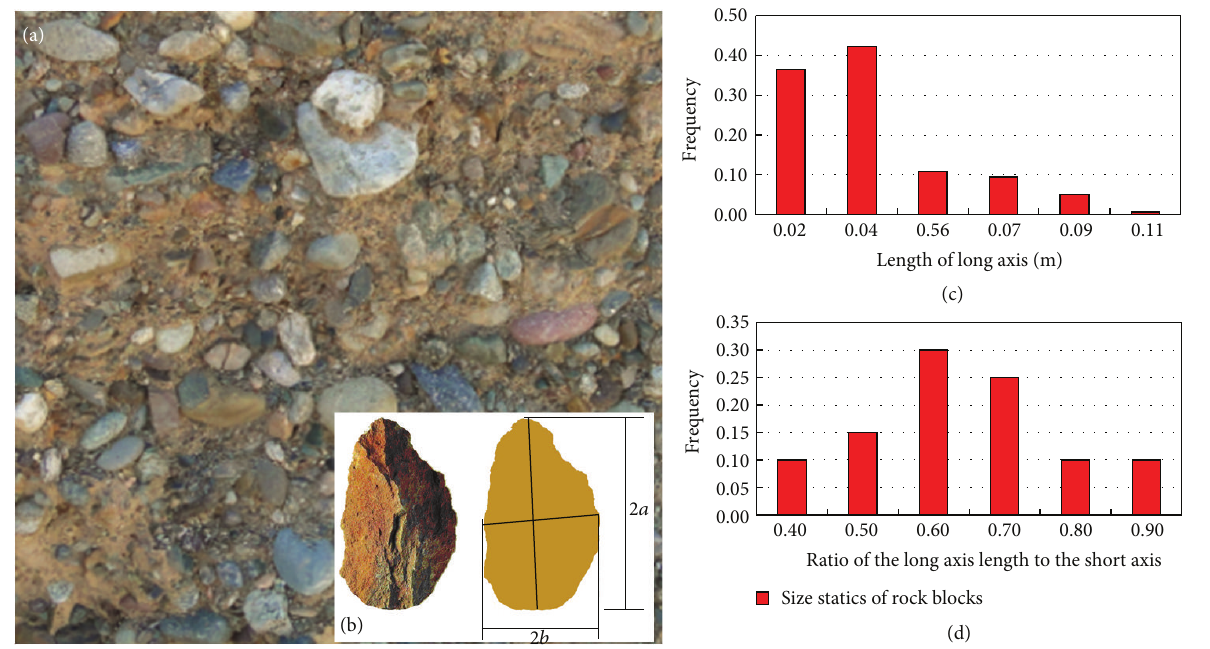
Figure 3: The statistical results of the size and the lengths of the long axis of stone blocks. (a) the in situ outwash deposits; (b) definition of the long axis and short axis for stone blocks; the long axis is the largest distance between vertices along the stone outline, while the short axis is the maximum segment length normal to the long axis direction; (c) the statistical results of the size of stone blocks; (d) the statistical results of the lengths of the long axis of stone